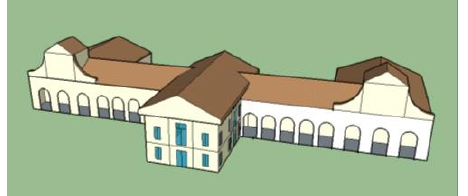
Figure 3. 3D Model of Villa Barbaro in Google SketchUp